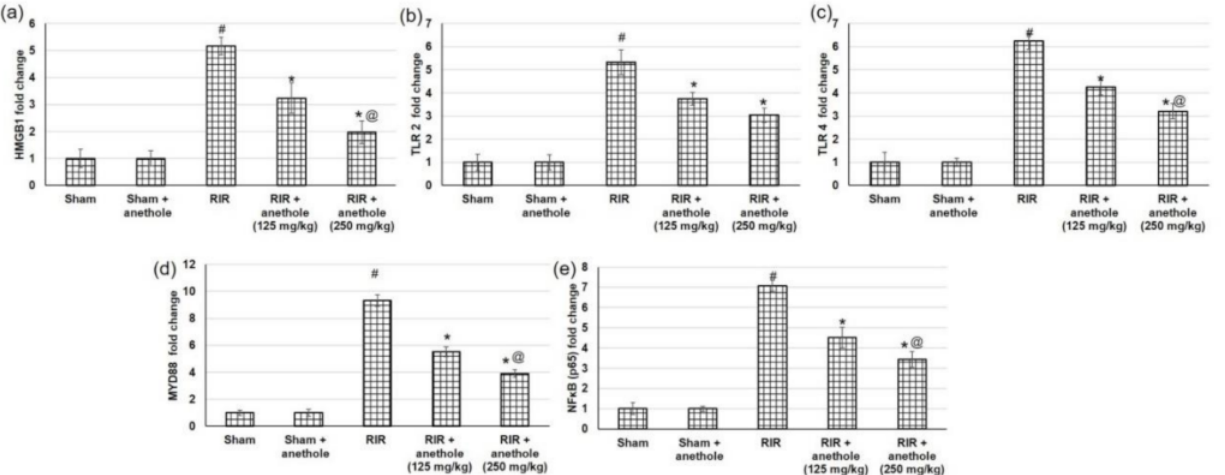
Figure 4. Effects of anethole (125 and 250 mg/kg) administration for 14 days prior to renal ischemia perfusion (RIR) on the renal gene (mRNA) expression of ( a ) HMGB1, ( b ) TLR2, ( c ) TLR4, ( d ) MYD88, and ( e ) NF κ B in RIR-induced injury. All values are stated as mean ± SD. # designates statistically significant compared to sham group, * designates statistically significant compared to RIR group, and @ designates statistically significant compared to RIR + anethole 125 mg/kg group ( p < 0.05) using one-way ANOVA followed by Tukey’s post hoc